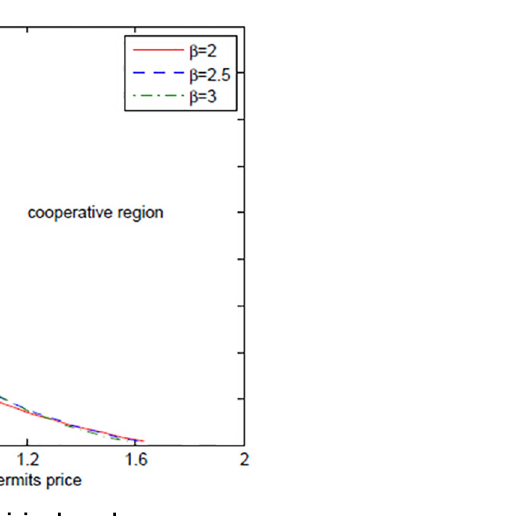
Fig 7. The effects of β on the optimal decision boundary.